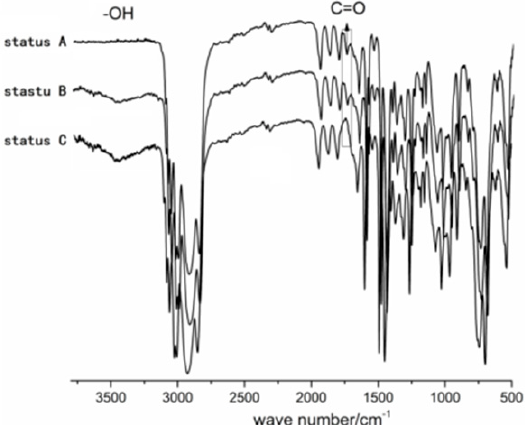
Figure 3. FT-IR data of three kinds of polymer statuses, status A = before adding iodopropanol, status B = after adding iodopropanol (before hydrolysis); status C =